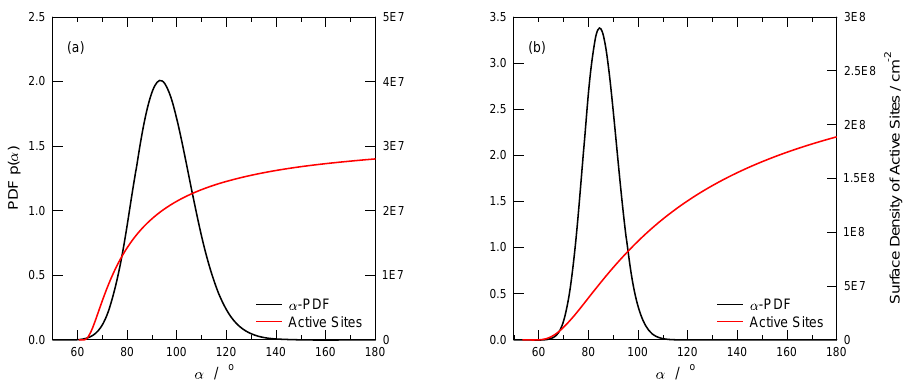
Fig. 8. Lognormal PDF p(α) (black line) and surface density of active sites distribution (red line) determined from immersion freezing data sets for all investigated a w for water and aqueous (NH 4 ) 2 SO 4 droplets containing leonardite (a) and Pahokee peat (b) . Note the different scales in panels (a) and (b)